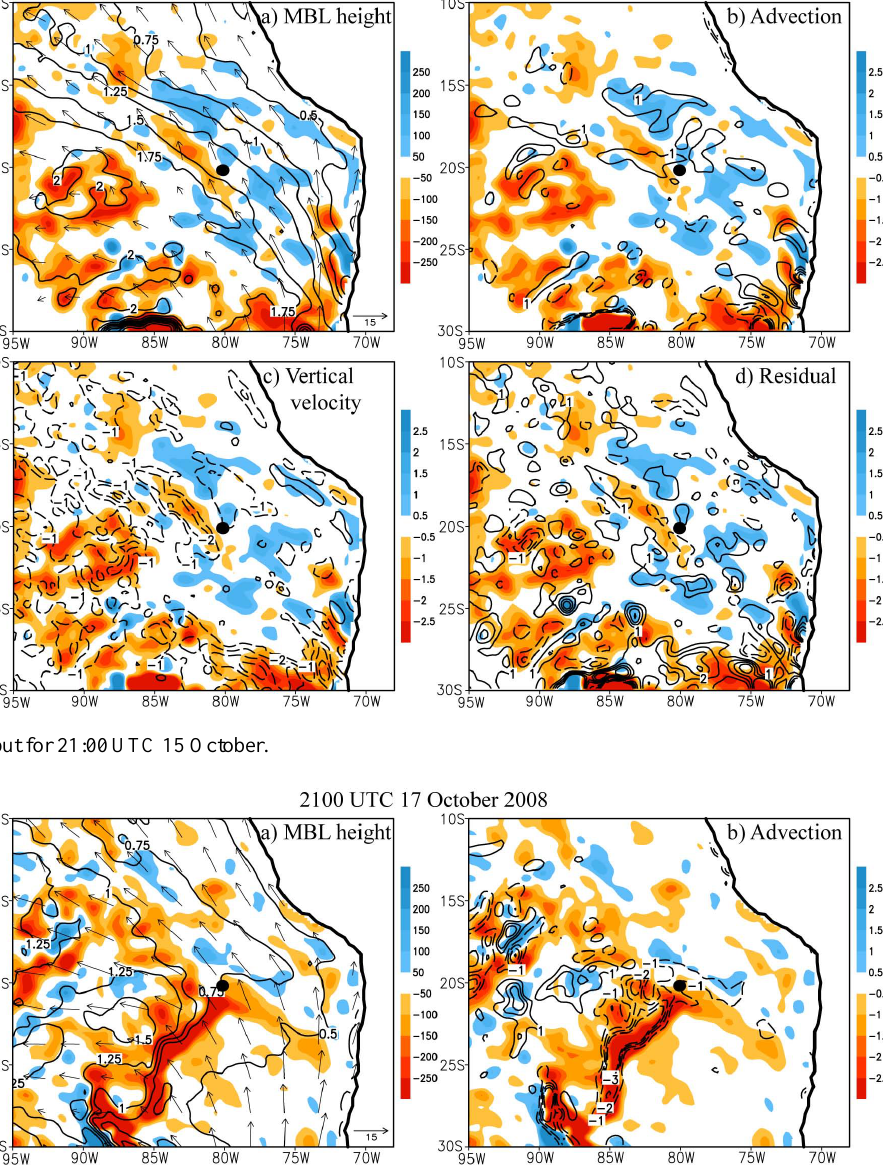
Fig. 12. As Fig. 10, but for 21:00UTC 17 October.